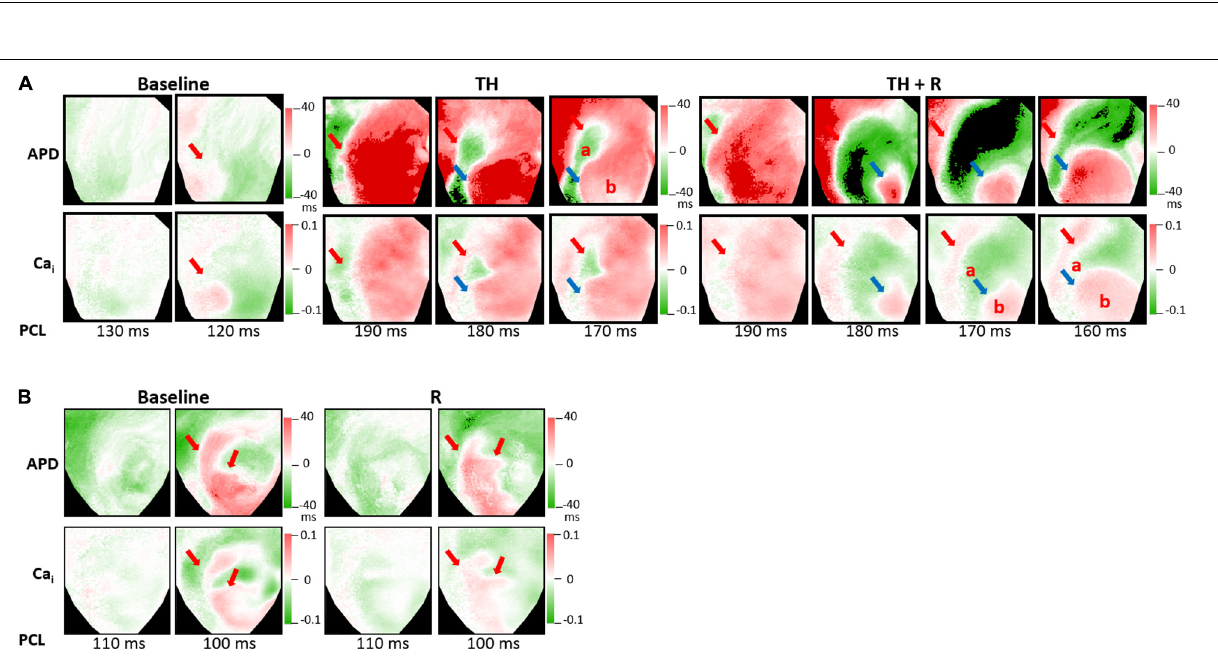
Frontiers in Physiology |